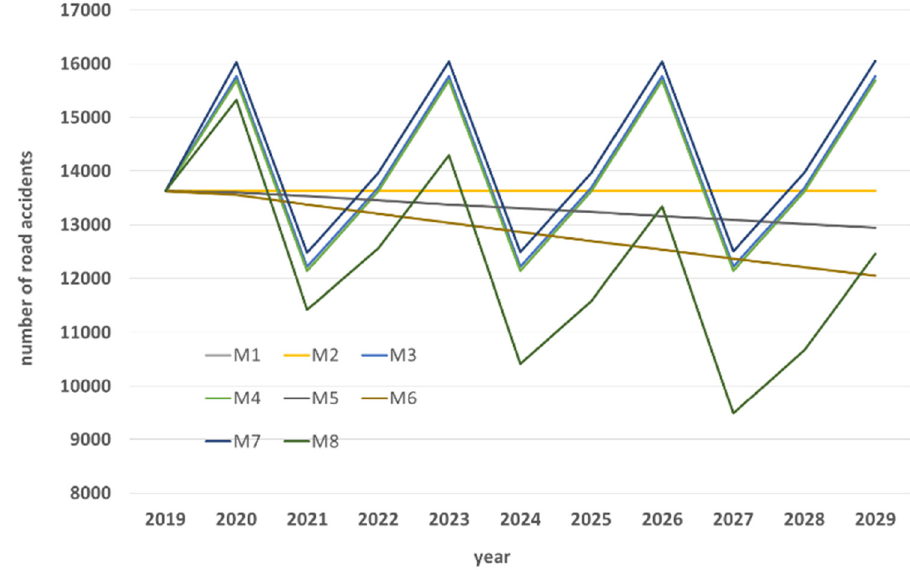
Figure 7: Forecasting the number of road accidents in Slovakia in 2020 – 2029 if there were no